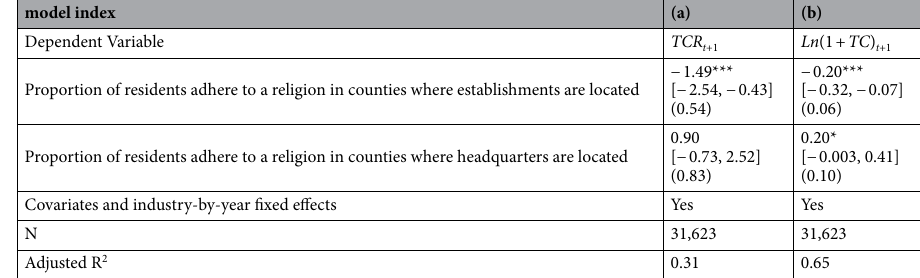
Table 3. The degree of religious affiliation in counties where establishments are located influences workplace injury rates more clearly than religious affiliation in the counties where an enterprise’s headquarters are located. Column (a) displays statistics from a model that regressed each private-sector establishment’s Total Case Rate of injuries, illnesses, and deaths (TCR)—as recorded by the United States Occupational Safety and Health Administration (OSHA) 40 from 2002 to 2011—on the proportion of residents acknowledging a religious adherence in its county and that in the county where its enterprise’s headquarter 30,33,34 is located plus a set of covariates and industry-by-year fixed effects. Column (b) reports the statistics from a model that regressed each private-sector establishment’s natural logarithm of one plus Total Cases of injuries, illnesses, and deaths (TC) 40 on those same variables. All coefficient estimates and associated statistics appear in the supplementary information, but we display the estimate for the focal coefficients—proportion of population adhere to a religion in the county where the establishment is located and that in the county where its enterprise’s headquarter is located—in the third row and fourth row of the table, following the model index and the listing of the dependent variable used in each model. The fifth row indicates whether the model involved covariates and binary indicators signaling the industry-year of a given record for an establishment. The second to last row lists the number of observations (N) and the final row displays the proportion of explained variance (R 2 ), adjusted for covariates. Asterisks denote the level of p values: *** p < 0.01, ** p < 0.05, * p < 0.10.